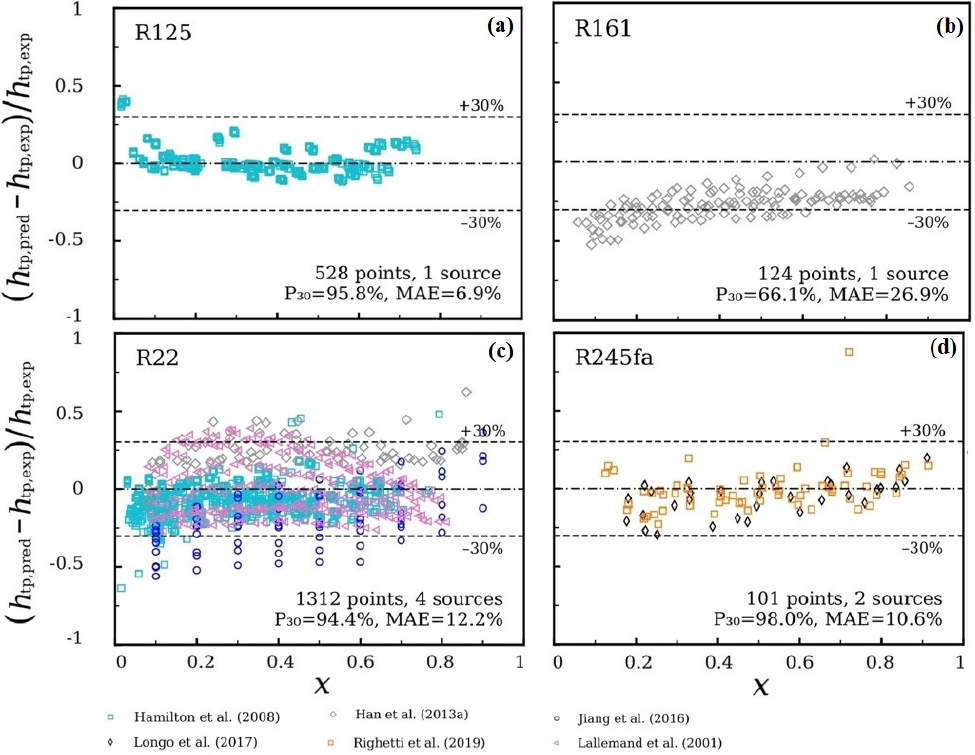
Figure 12. Comparison of different models on the basis of relative residuals to Lin et al. [120] model versus vapor quality for refrigerants ( a ) R125, ( b ) R161, ( c ) R22, and ( d ) R245fa.